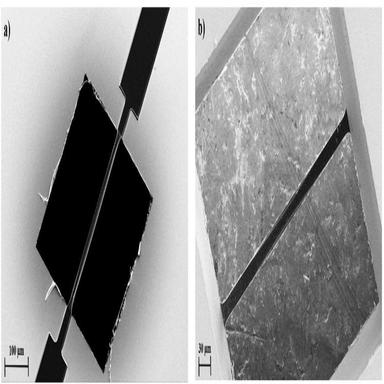
Pyrolytic carbon string resonator (400 x 30 m) fully suspended over a through-wafer-orifice imaged from a) the front side and b) the backside of the wafer.